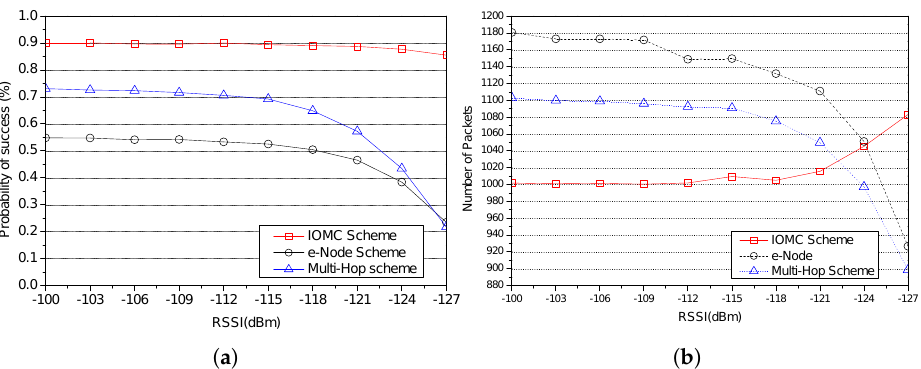
Figure 7. Plot variations in link quality (RSSI) with probability of success and number of packets for various schemes. ( a ) The probability of success as a function of RSSI (dBm). ( b ) Number of packets as a function of